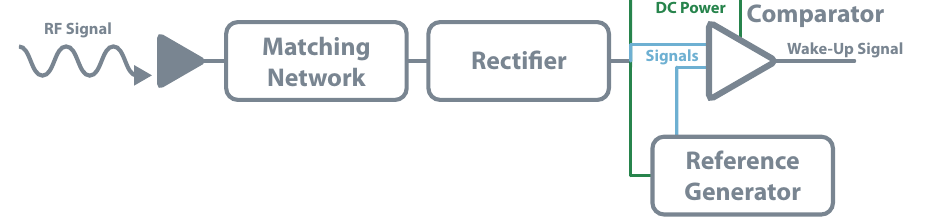
Figure 17. WUR—passive